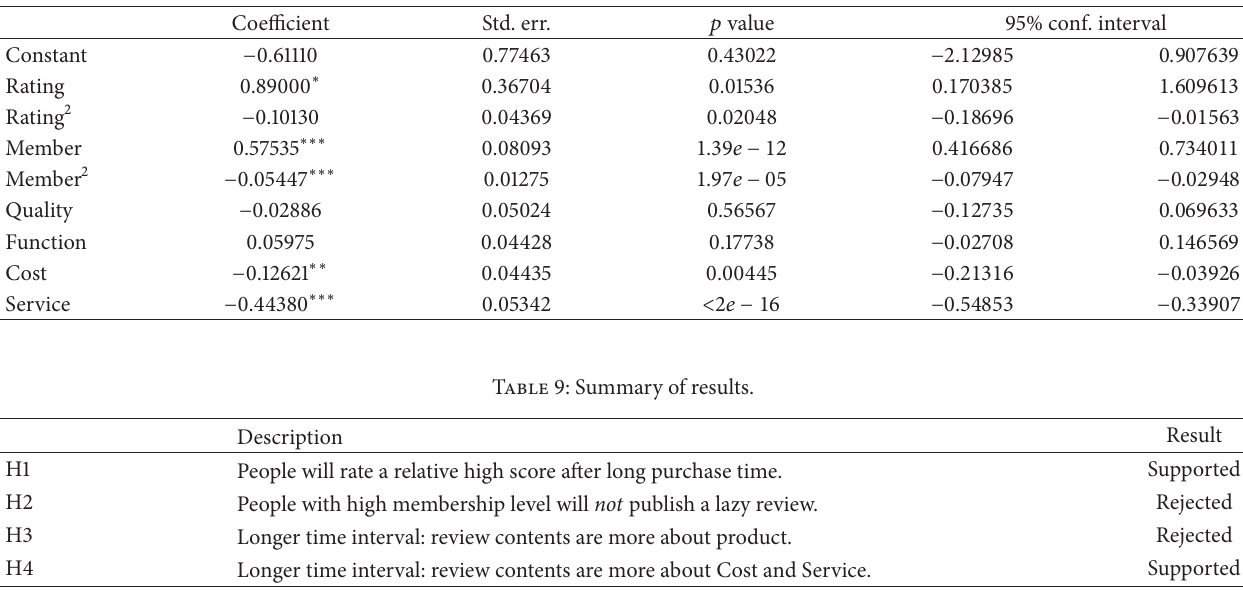
Table 8: Results of regression analysis ( ∗ 𝑝 < 0.05; ∗∗ 𝑝 < 0.01; ∗∗∗ 𝑝 < 0.001).